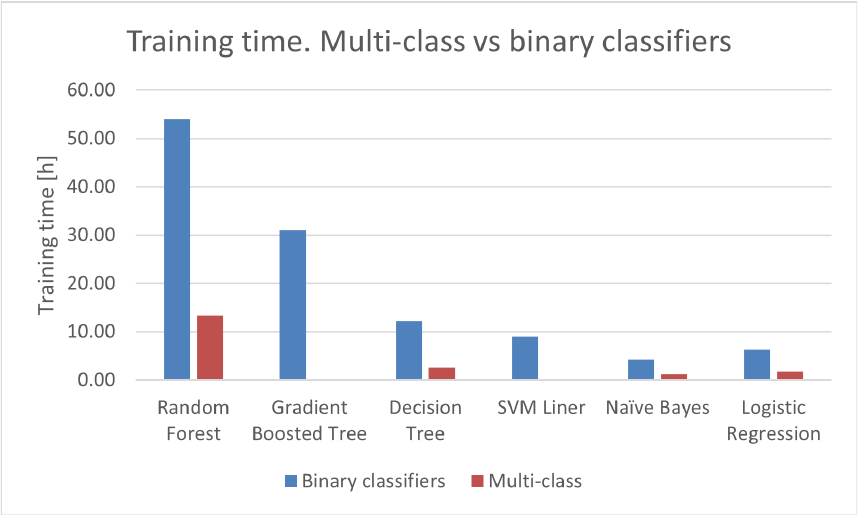
Figure 5. Training time for Multi-class vs. Binary classifiers with OVR in Spark.